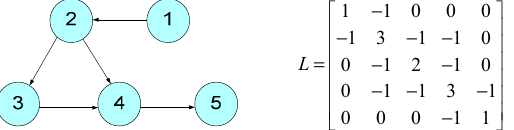
Figure 4. Communication topology with multi-agent system and its Laplacian.